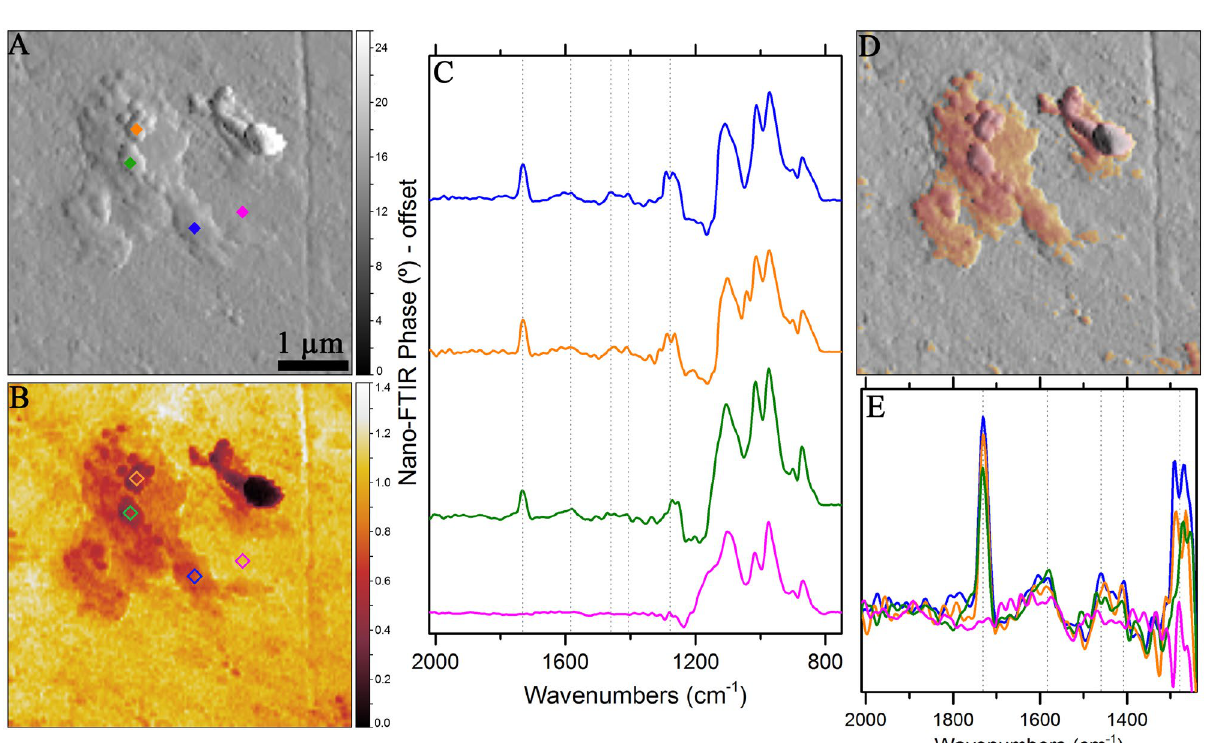
Figure 2. Nano-FTIR spectroscopic investigation of a location in DOM 08006. ( A ) Mechanical and ( B ) optical amplitude images of the measured area. Diamonds in ( A ) and ( B ) denote the points from where the spectra were collected. ( D ) The overlaid amplitude images indicating the boundaries and features of the organic compounds. ( C ) Corresponding color-coded nano-FTIR spectra. ( E ) Close up view of the organic peaks observed within 2000–1250 cm −1 in DOM 08006. Dashed lines indicate the positions of prominent organic